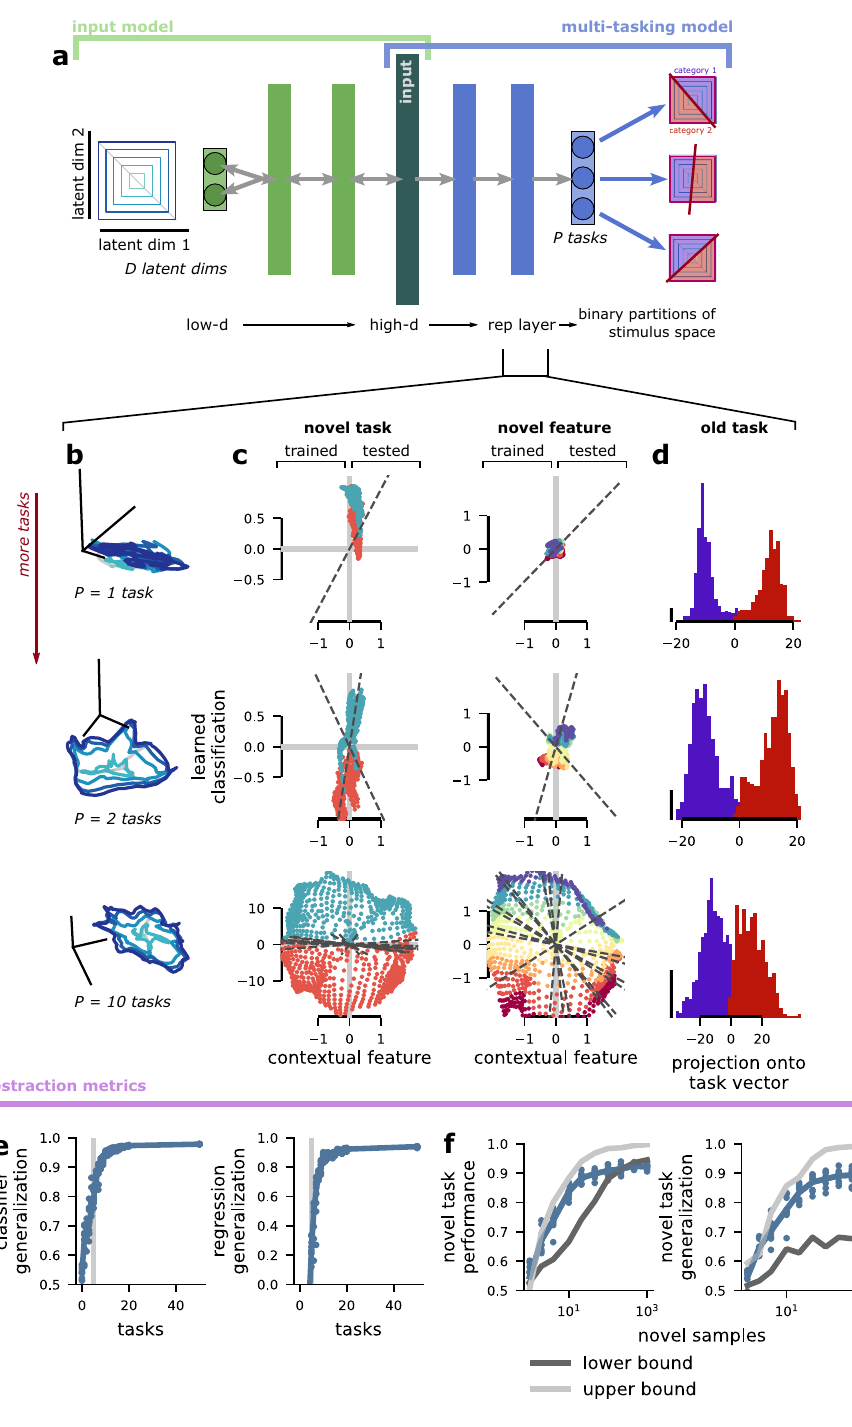
training procedure, abstract representations begin to emerge (Fig. 3b, middle). In particular, the representation layer is dominated by a two- dimensional abstract representation of a linear combination of two of the latent variables. Next, we demonstrate that this abstract structure becomes more complete as the number of tasks included in the training is increased. For P = 10 and D = 5, the visualization suggests that the representation has become fairly abstract (Fig. 3b,